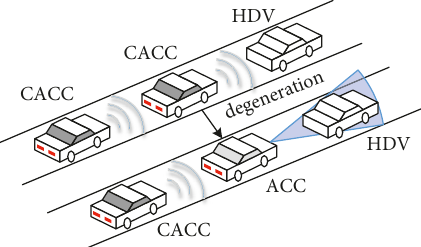
Figure 2: Car-following degradation in mixed traffic